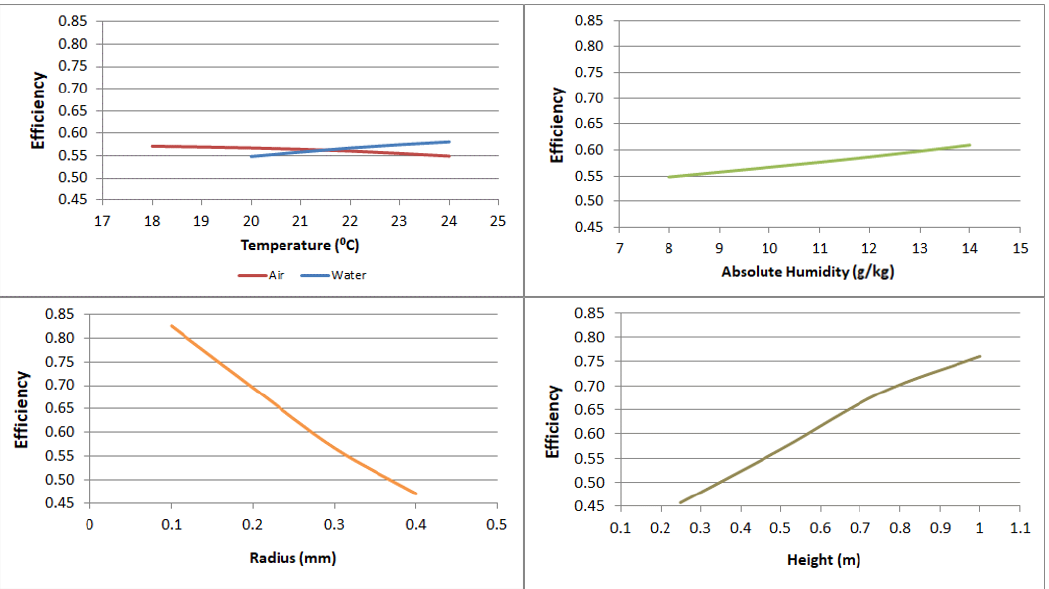
Figure 5. Effect of model variables on efficiency (see Equation (5)). Figure 5. E ff ect of model variables on e ffi ciency (see Equation